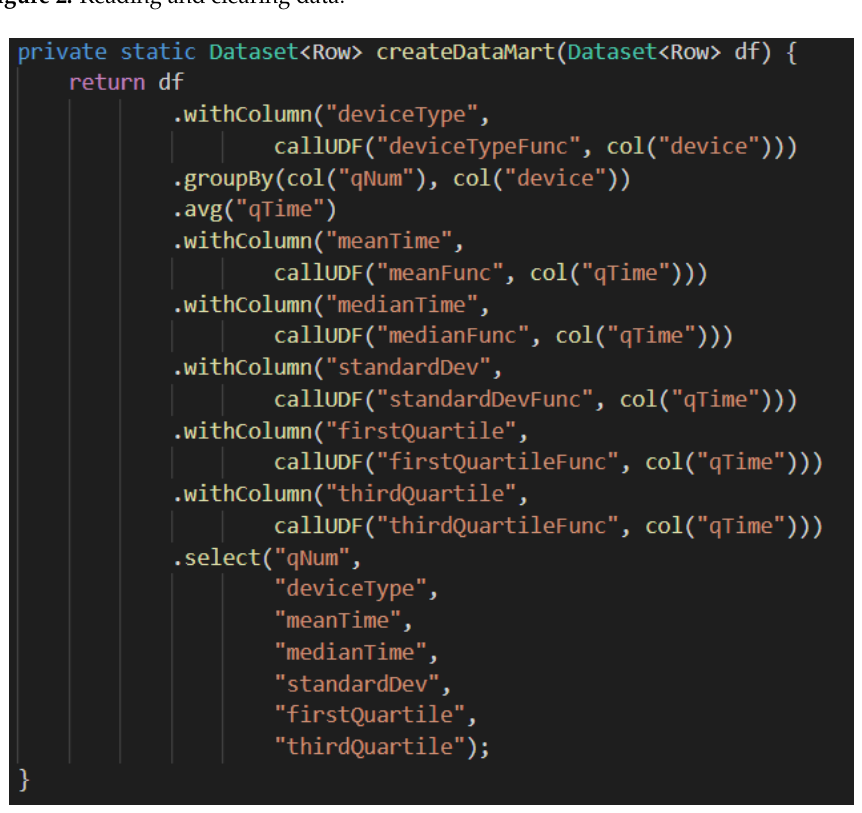
Figure 2. Reading and clearing data.